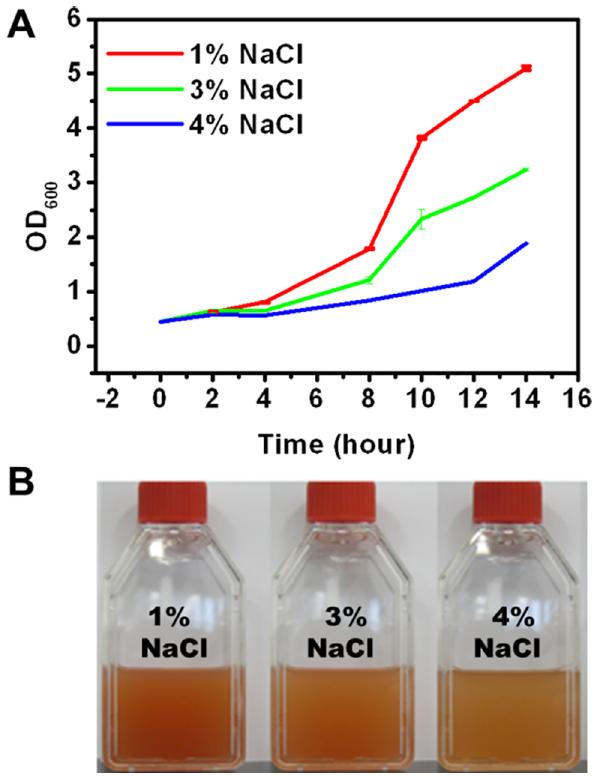
Fig 3. Analysis of A . andensis ANESC-S T resilience to different salt concentrations. (A) Growth curves of A . andensis ANESC-S T in LB broth with varied NaCl concentrations (Initial OD 600 (cid:2) 0.4). (B) A . andensis ANESC-S T was inoculated and cultured for 14 hours in LB broth with varied NaCl concentrations (Initial OD 600 (cid:2) 0.4).